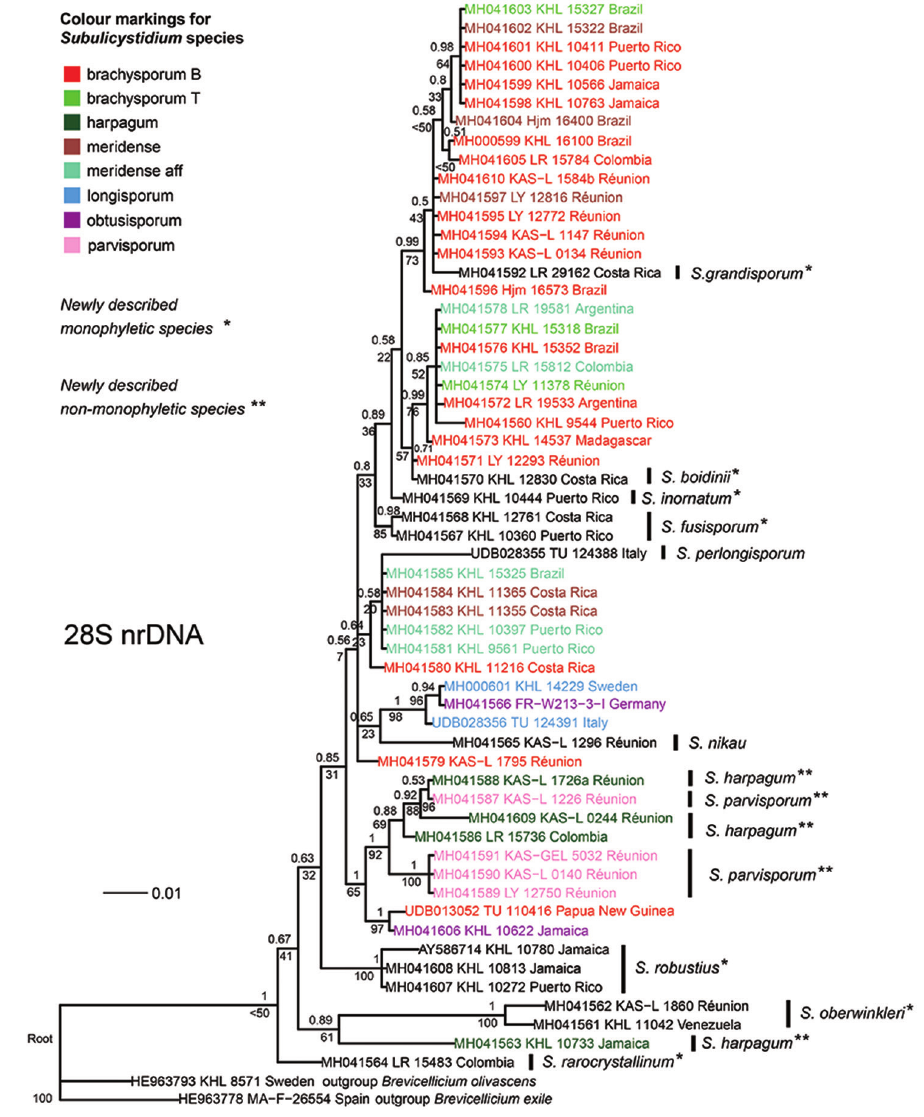
Figure 13. Phylogenetic relationship of Subulicystidium based on 28S nrDNA sequences. 50% major- ity-rule consensus tree from Bayesian analysis is shown, with posterior probabilities above the branches and bootstrap support values from the maximum likelihood estimation below the branches. Tips of the tree are annotated according to morphological identification and marked with colours in non-monophy- letic taxa (see legend). In the legend, the capital “B” following epithet in S. brachysporum means mor- phological species concept following Boidin and Gilles (1988), while “T” means the species as described by Talbot